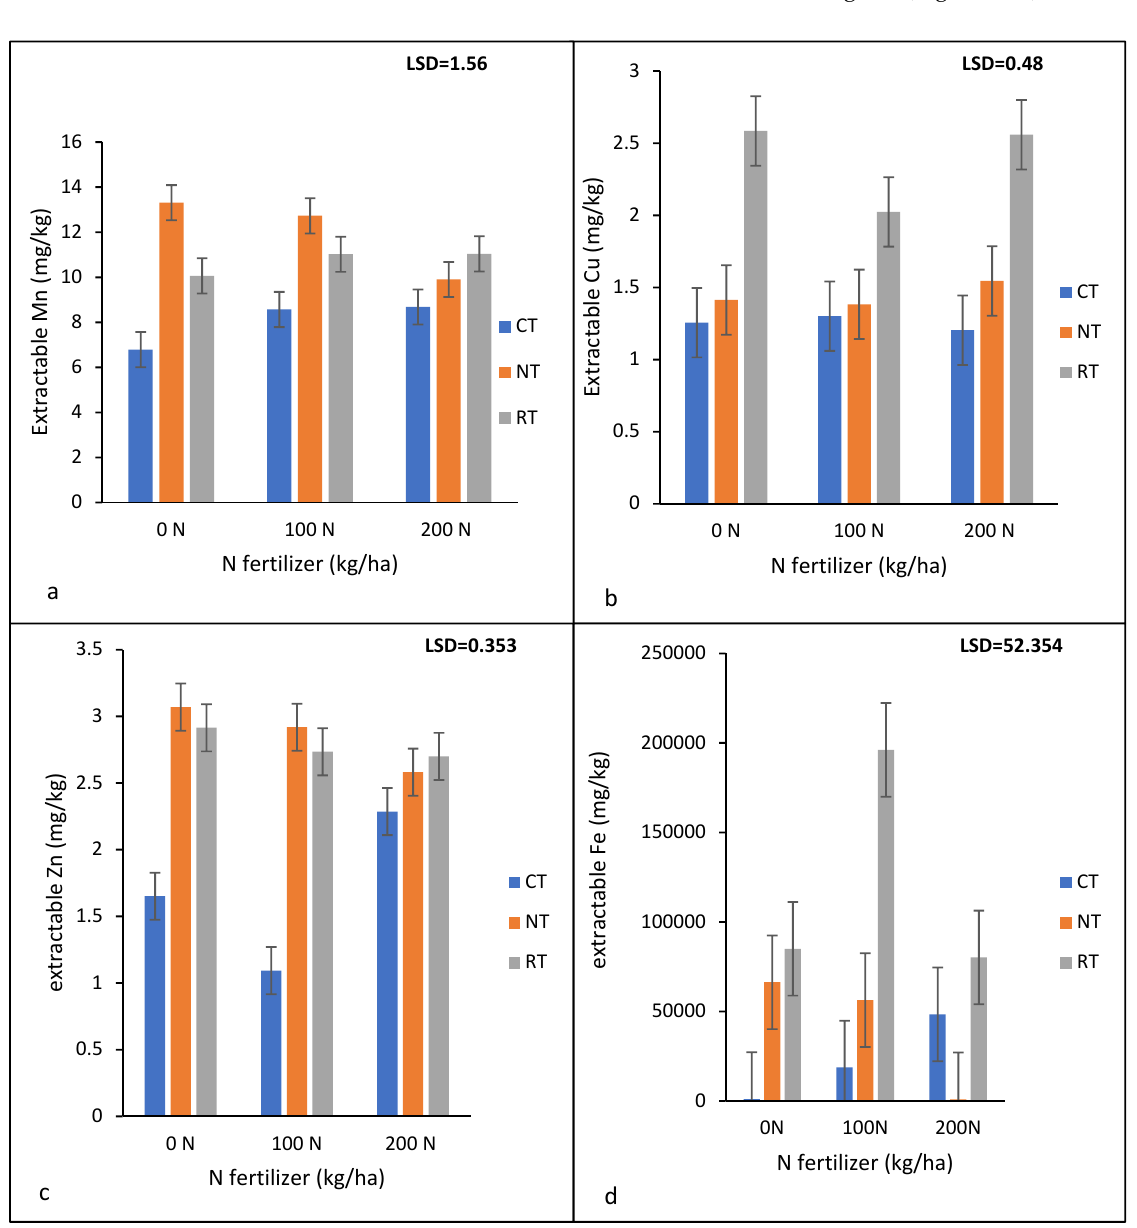
Figure 10. The concentration of extractable micronutrients [manganese (Mn) ( a ), copper (Cu) ( b ), zinc (Zn) ( c ) and iron (Fe) ( d )] in three treatments of nitrogen (Urea) at 0, 100 and 200 kg/ha recorded after 17 years of trial establishment. N= nitrogen fertilizer. CT = conventional tillage, RT = rotational tillage, NT = no-till.